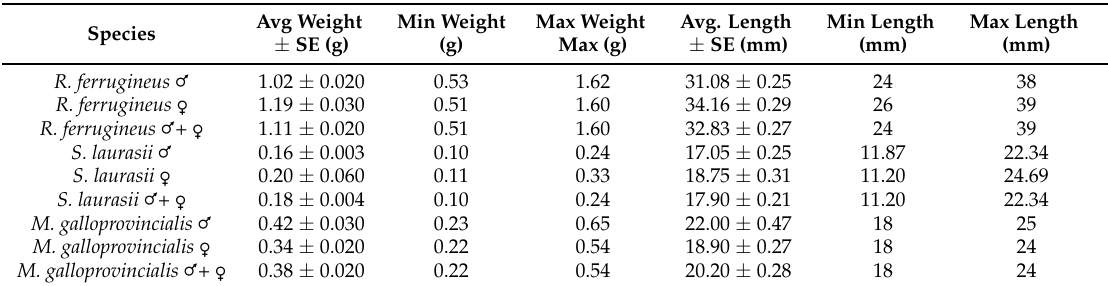
Table 2. Main morphological characteristics, body weight and body length, for males and females of the different tested species.